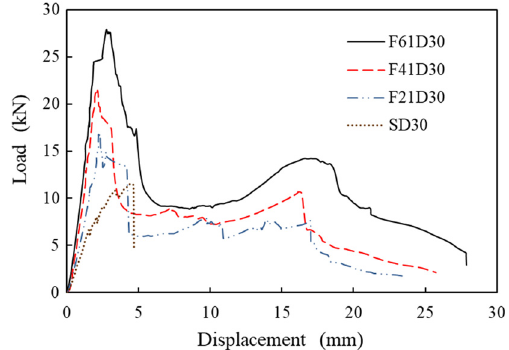
Figure 5: Effect of the number of FRP layers on facesheets.